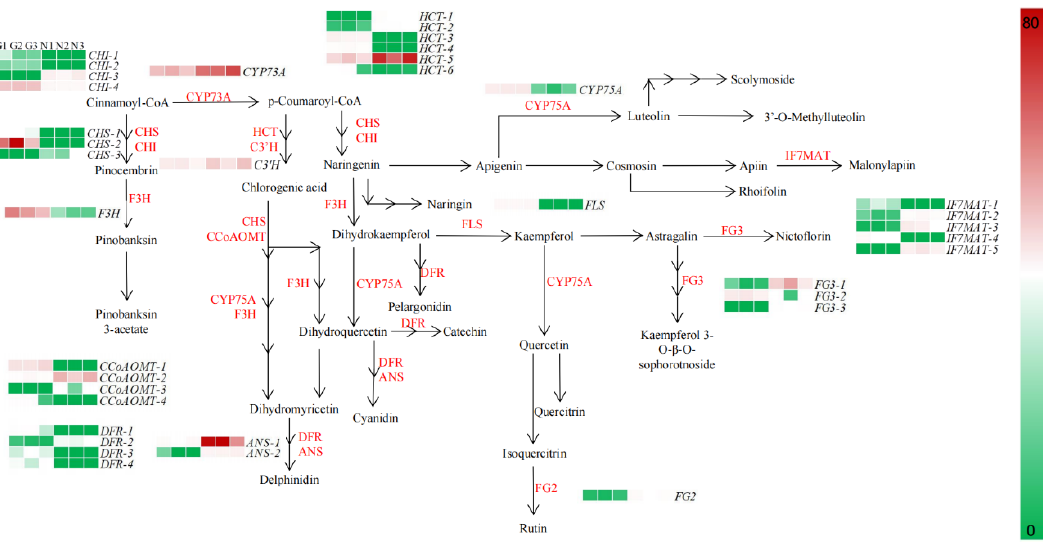
Figure 6. Expression patterns of flavonoid biosynthesis-related genes in flowers of G type and N type.